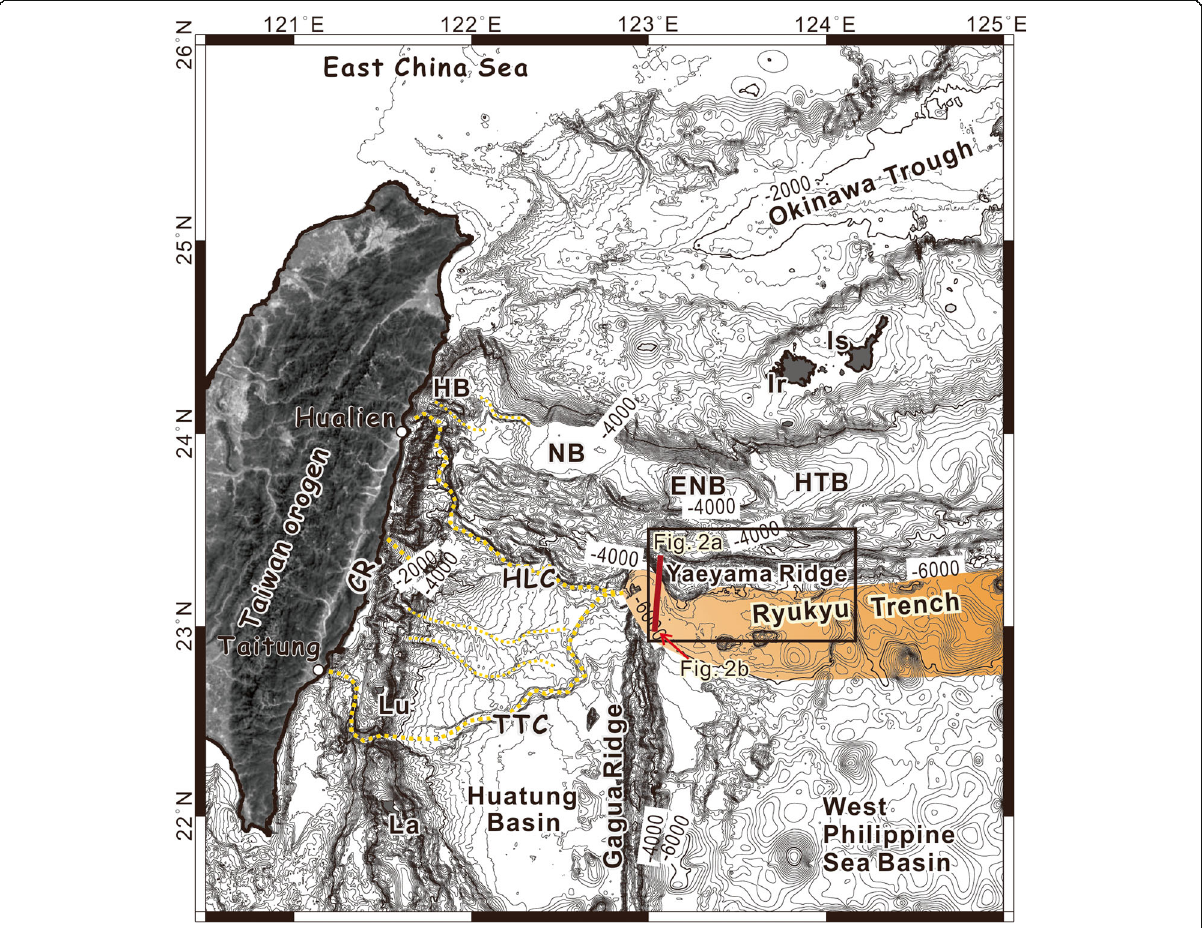
Fig. 1 Regional bathymetric map of the southwestern Ryukyu subduction zone between Taiwan and Iriomote Island. The southwestern Ryukyu Trench (shaded orange) terminates at Gagua Ridge, which separates the Huatung and West Philippine Sea basins. Several large canyons (yellow broken lines) incise the narrow slope off eastern Taiwan and extend into the Huatung Basin. CR, coastal range; HB, Hoping Basin; NB, Nanao Basin; ENB, East Nanao Basin; HTB, Hateruma Basin; Ir, Iriomote Island; Is, Ishigaki Island; HLC, Hualien Canyon; TTC, Taitung Canyon; and Lu and La, Lutao-Lanyu Ridge (i.e., the Luzon arc). The square indicates the area shown in Fig. 2a, and the red solid line the location of seismic reflection profile line 89 (Fig.